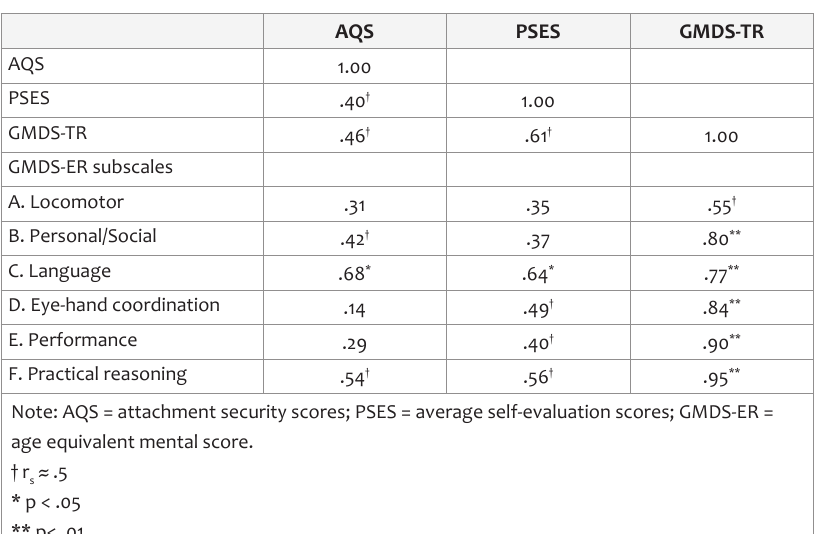
): Inter-scale correlations s